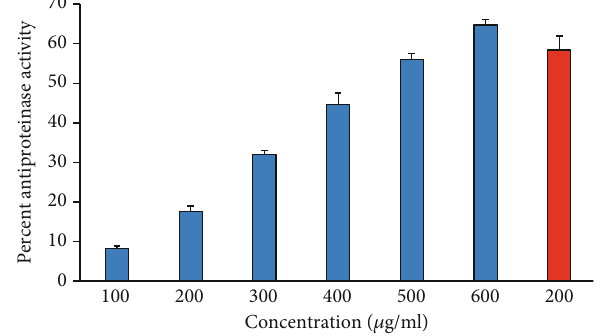
Figure 4: Antiproteinase activity of 6-gingerol. Samples 1-6 represent various concentrations (100-600 μ g/ml) of 6-gingerol. Last two samples 7 and 8 contained 100 and 200 μ g/ml of diclofenac